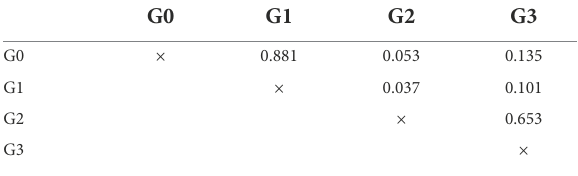
TABLE 7 One-way ANOVA test for different layouts (correct